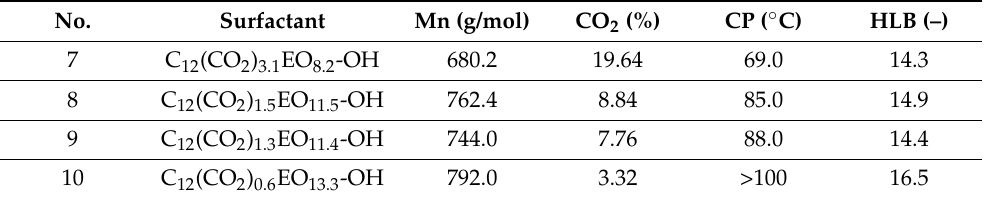
Table 2. Summarized data of Mn, Mw, CO 2 content, CP, and HLB values for all surfactants with the carbonate-modified head groups. Reprinted with permission from Ref. [25] 2023,